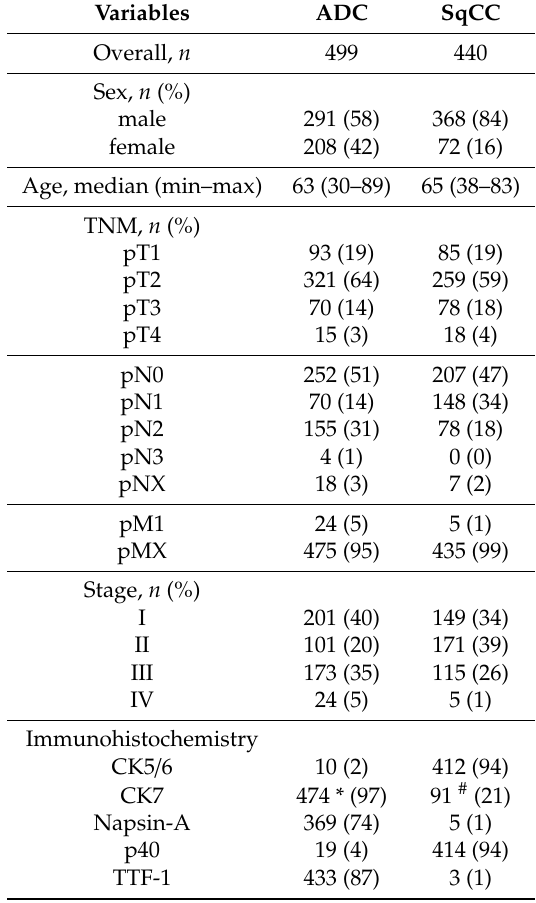
Table 1. Patient characteristics and immunohistochemical staining